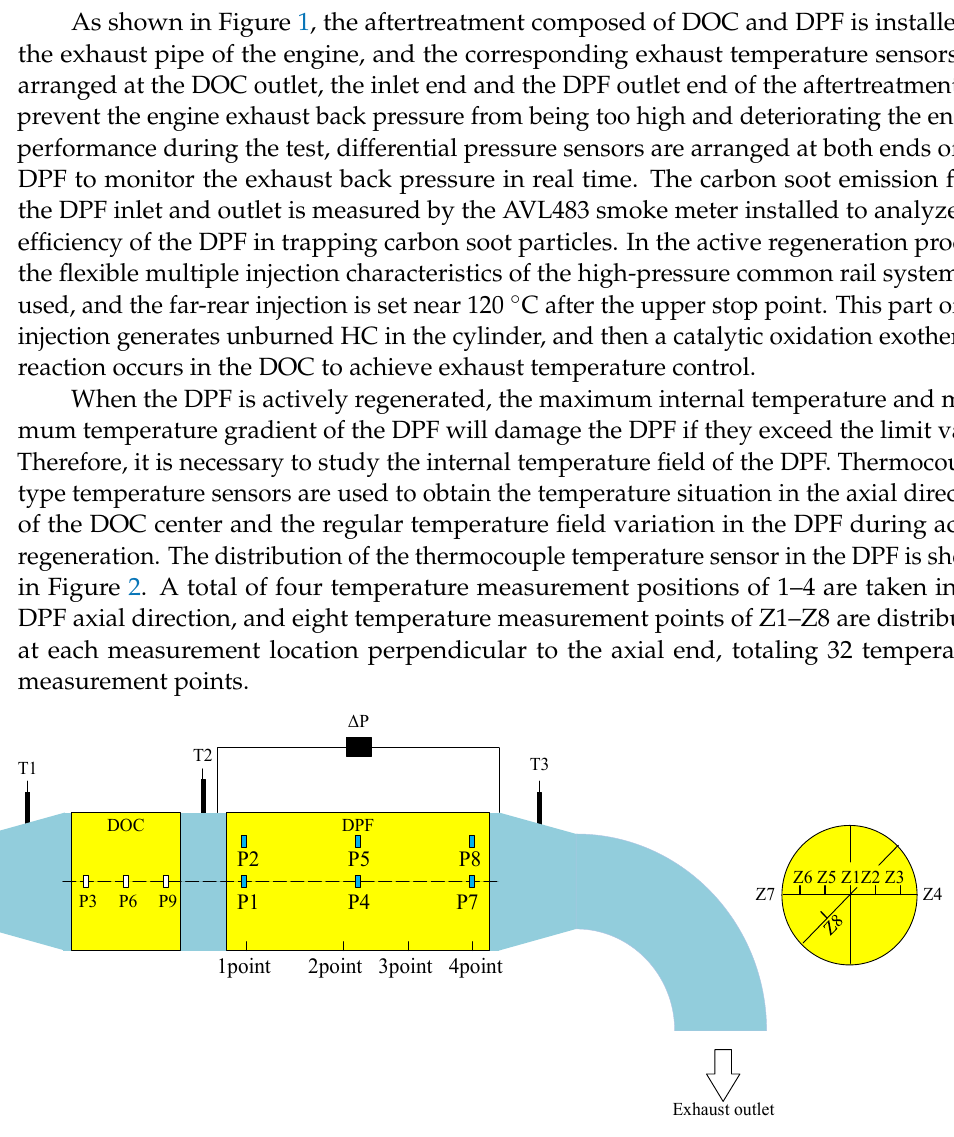
Figure 1. Schematic diagram of the engine test bench.